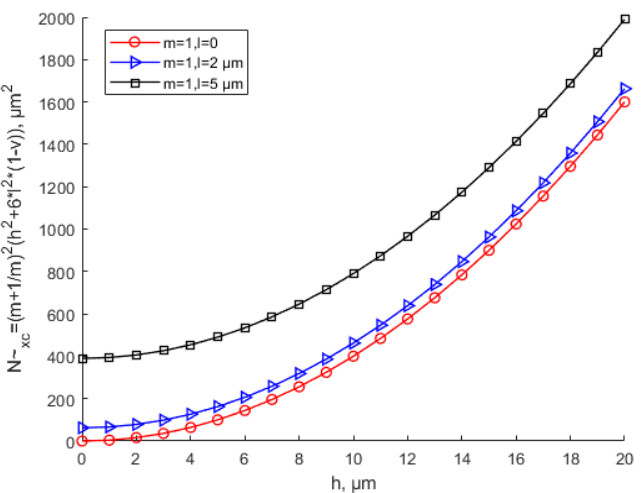
Figure 9. Variation in the equivalent critical buckling load with various values of the scale parameter.